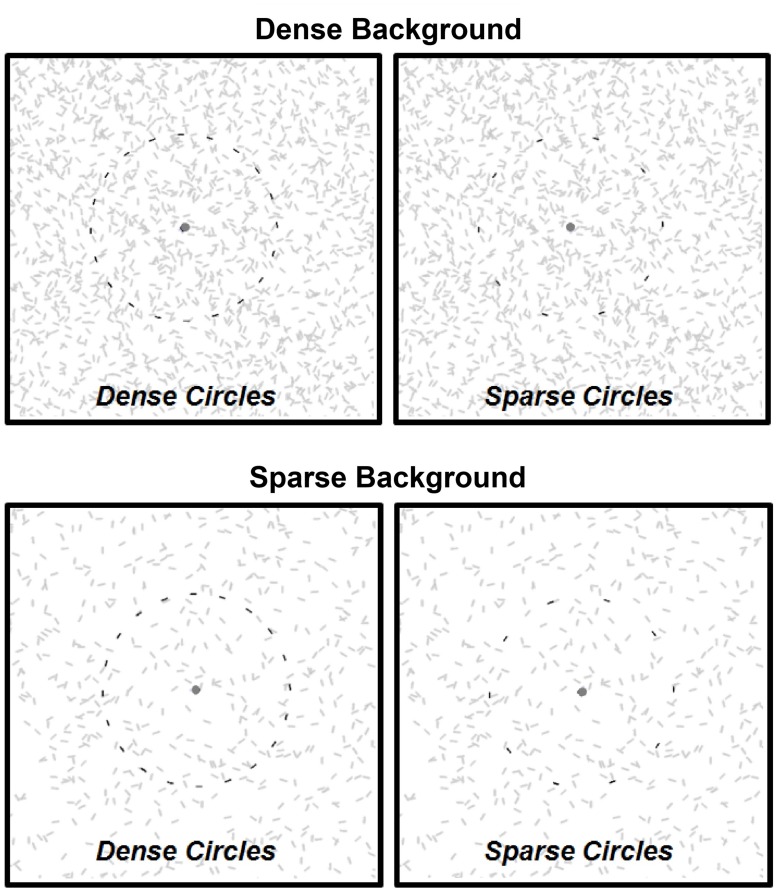
Circles of different three densities appeared against backgrounds of three different densities; two of extremes for each shown here. Non-smooth circles were identical to those shown except that the orientation of each element was random. The circles shown here are darkened for purpose of illustration only; all line segments were of equal luminance during the experiment (see Materials and Methods).